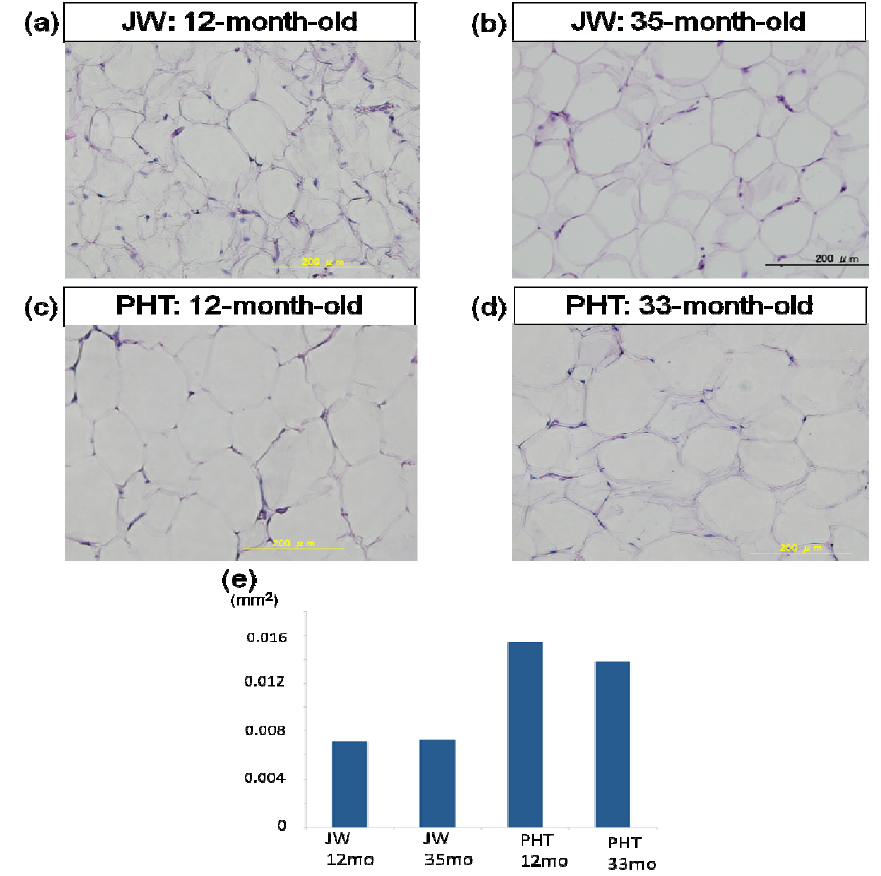
Figure 4. Effect of hypertriglyceridemia on the size of adipose cells. Histological examination of adipose cells ( a – d ) and size of adipose cells ( e ); Each tissue was fixed in formaldehyde and embedded in paraffin. They were sliced (4 μ m) and stained with hematoxylin-eosin solution. ( a ) 12-month-old JW rabbit; ( b ) 35-month-old JW